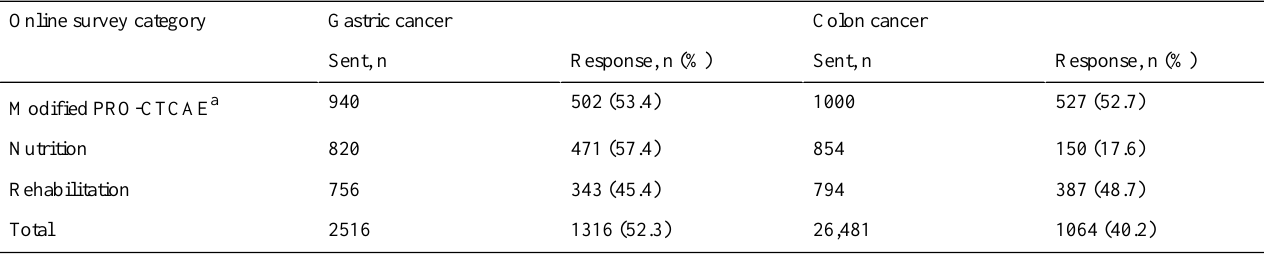
Table 5. Response rate for online